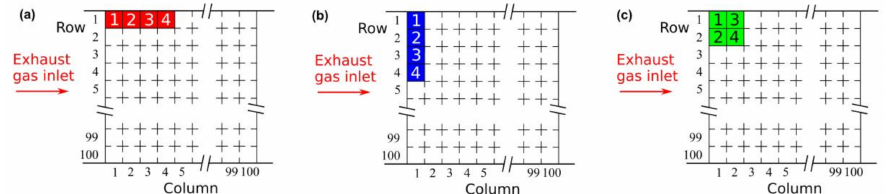
Figure 2. Schematic view of the spatial distribution of individual TEMs in the ATEG for the ( a ) se- ries configuration, ( b ) parallel configuration, and ( c ) square configuration. The example shown corresponds to the case with 4 TEMs.